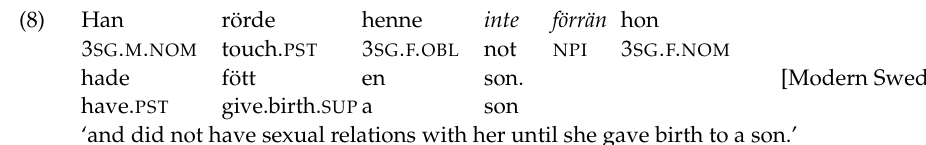
Figure 1. Semantic map of temporal clauses following Kortmann (1997, p.